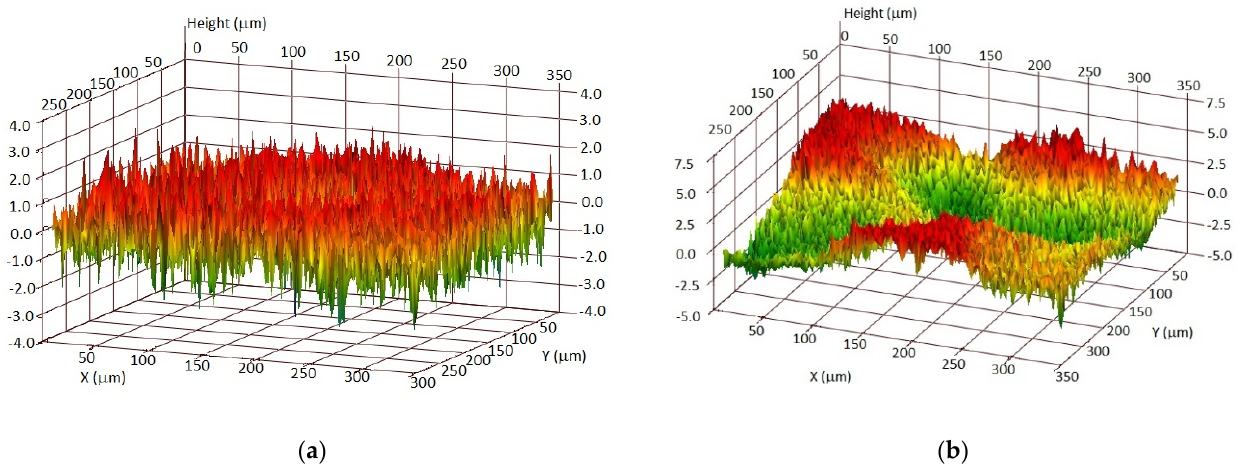
Figure 2. The topography of the tested crude surface before deposition of a varnish coating: after chemical cleaning ( a ) and after abrasive blasting ( b ).